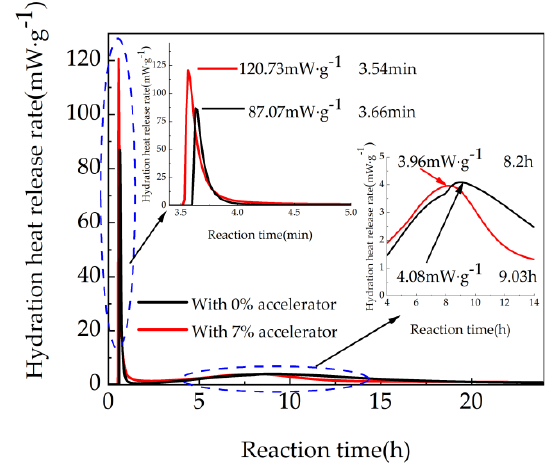
Figure 8. Hydration heat release rate curve.